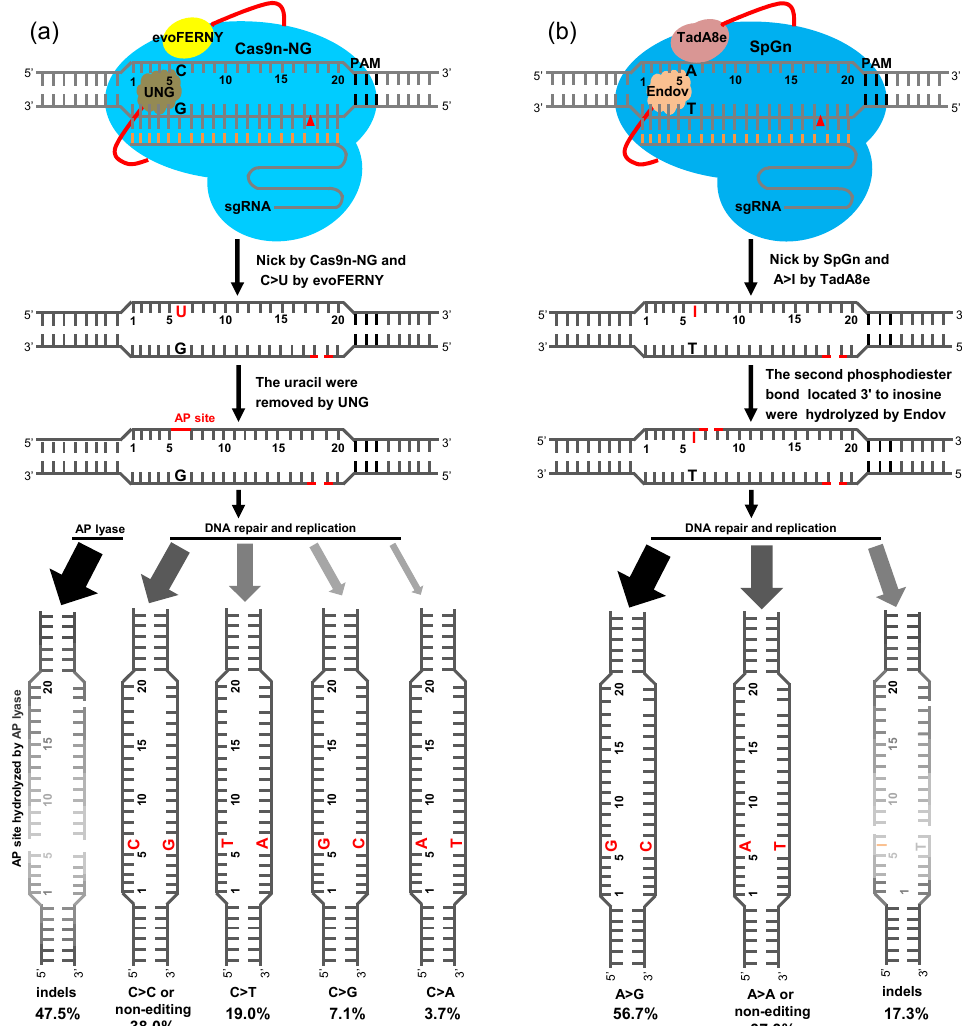
Figure 4. Plant CGBE- and ABE8e-EndoV-mediated excision repair pathway. ( a ) In the U base excision repair (BER) pathway of CGBE-rUNG and CGBE-hUNG, C bases in the editing window are deaminated by cytosine deaminase evoFERNY to U, U bases are excised by UNG to form an apurinic/apyrimidinic (AP) site, and then two repair pathways are initiated. In one of these pathways, the AP site is hydrolyzed by AP enzymes and activated by non-homologous end repair, leading to several indels, whereas in the other pathway, the AP site generates C-to-T, C-to-G, and C-to-A substitutions or restores original C after DNA repair and replication pathways. ( b ) The I base is the alternative BER (AER) pathway of ABE8e-EndoV. Bases are deaminated by adenine deaminase TadA8e to I, and the second phosphodiester bond located at the 3 ′ -terminus of I bases is hydrolyzed by EndoV, resulting in A-to-G substitutions or the restoration of original A after DNA repair and replication. In addition, some indel mutations are generated after non-homologous end-joining repair. The gray area indicates the degree to which the indel frequency is generated.